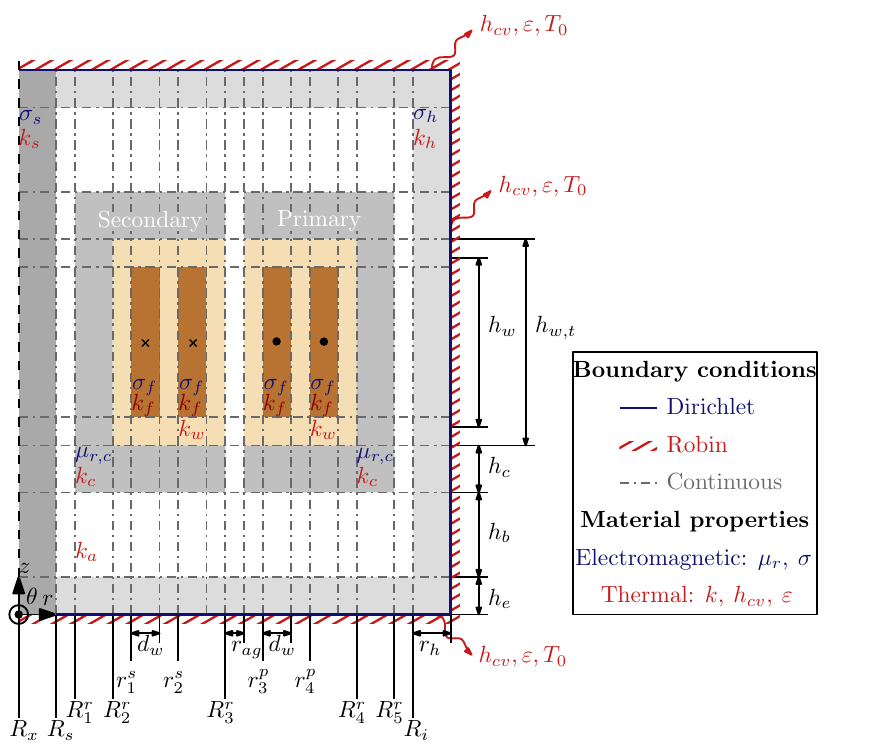
Figure 2. Overview of the benchmark system with axisymmetry, including indication of the boundary conditions, element discretization, geometrical parameters, and material properties in both the electromagnetic and thermal domain. Table 1. Geometrical parameters and physical quantities of the